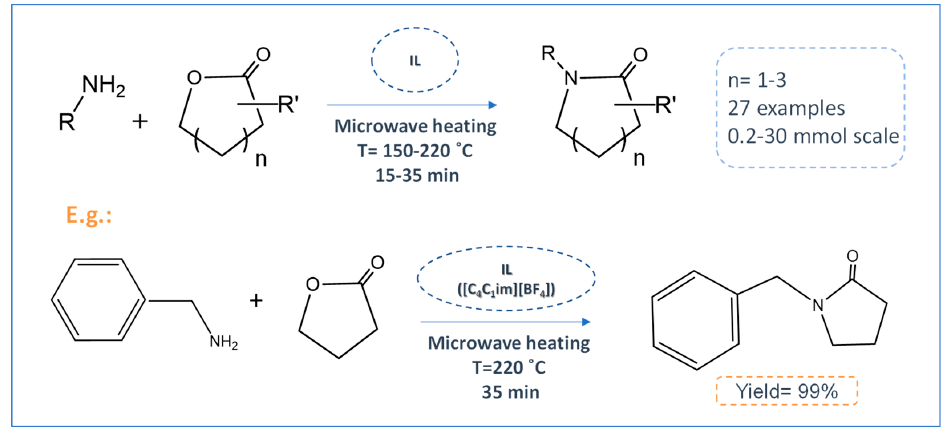
Figure 3. Fast and acid-free one-pot IL-based microwave methodology for direct synthesis of lactams from lactones and primary amines proposed in [41].